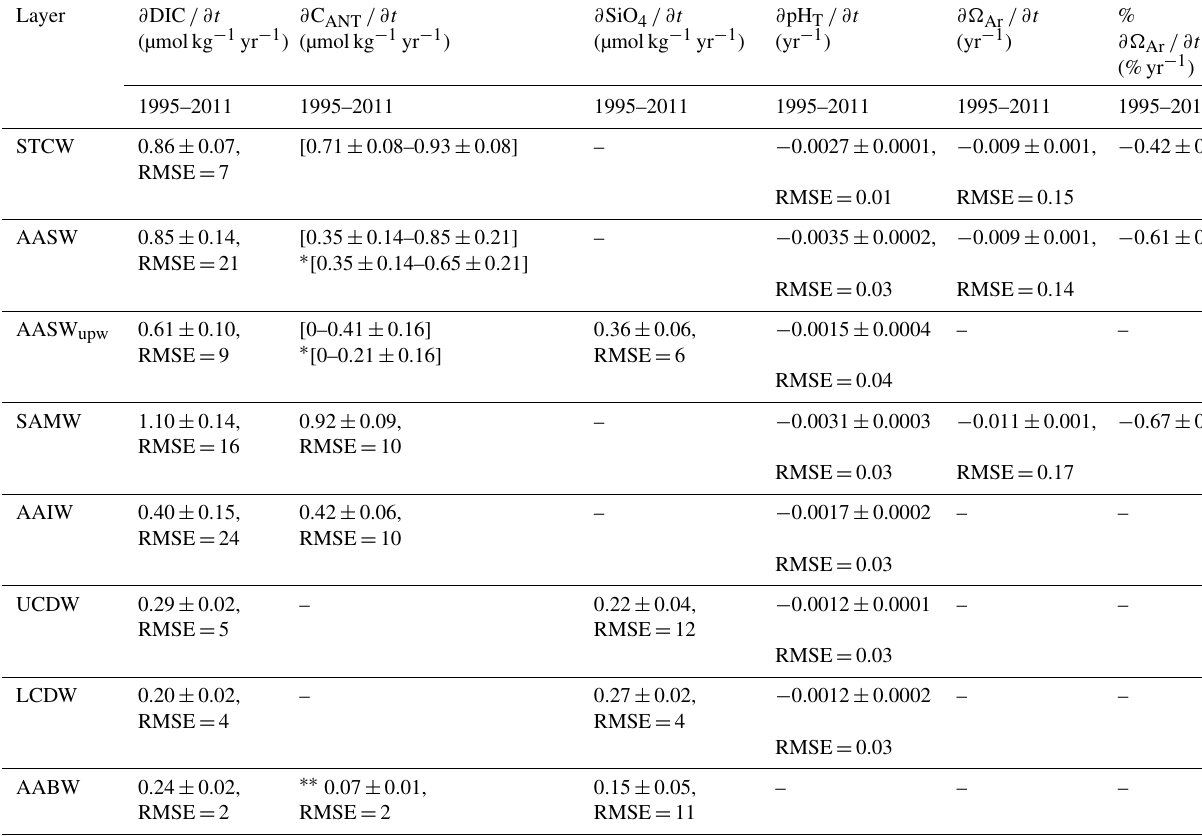
Table 4. Trends in the water mass layers for the period 1995–2011 of dissolved inorganic carbon ( ∂ DIC /∂t ), anthropogenic carbon ( ∂ C ANT /∂t ), silicate ( ∂ SiO 4 /∂t ) total pH ( ∂ pH T /∂t ), aragonite saturation ( ∂(cid:127) Ar /∂t ) and percentage of change in the aragonite satura- tion (% ∂(cid:127) Ar /∂t ). RMSE = root mean square error. ∗ Trends in C ANT for the AASW and AASW upw layers considering an approximate value for the increase in DIC due to the advection of old deep waters to the section (see Sect. 4.4.1 in the text). ∗∗ The value of ∂ C ANT AABW layer is considered negligible because it falls below the accuracy of the back-calculation method.